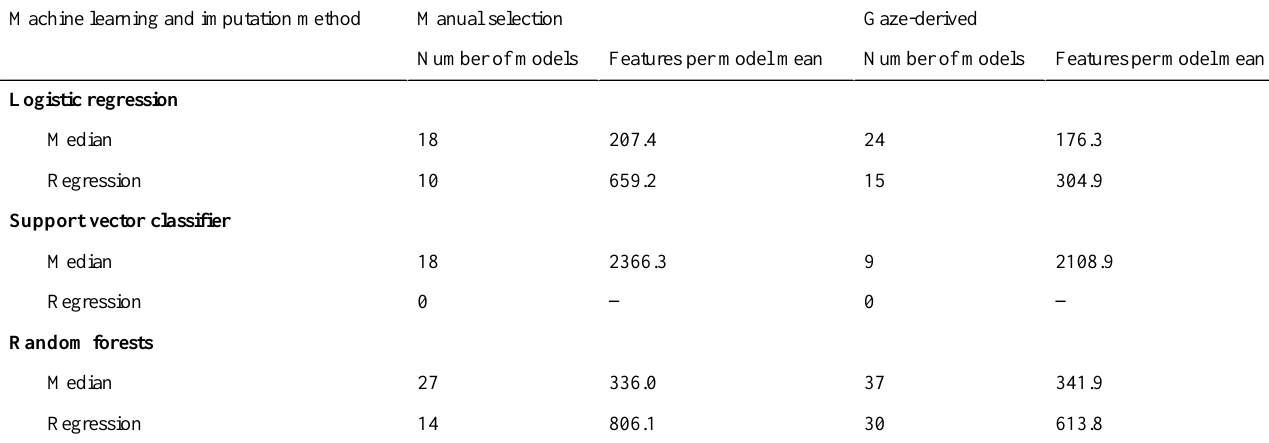
Table 3. Summary of machine learning methods, imputation methods, number of models of each combination of machine learning and imputation methods, and number of features per